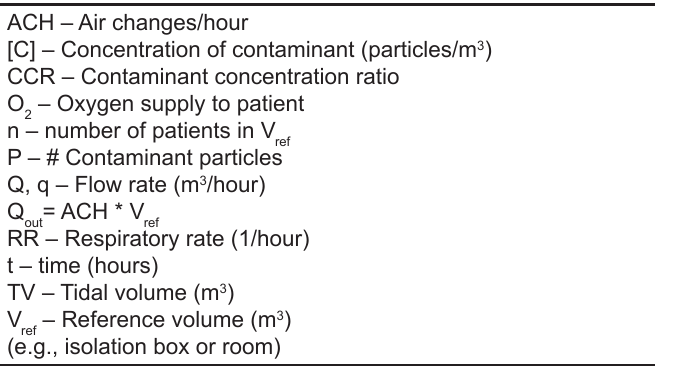
Table 1. Definitions of terms used to measure air contamination caused by aerosolized components.